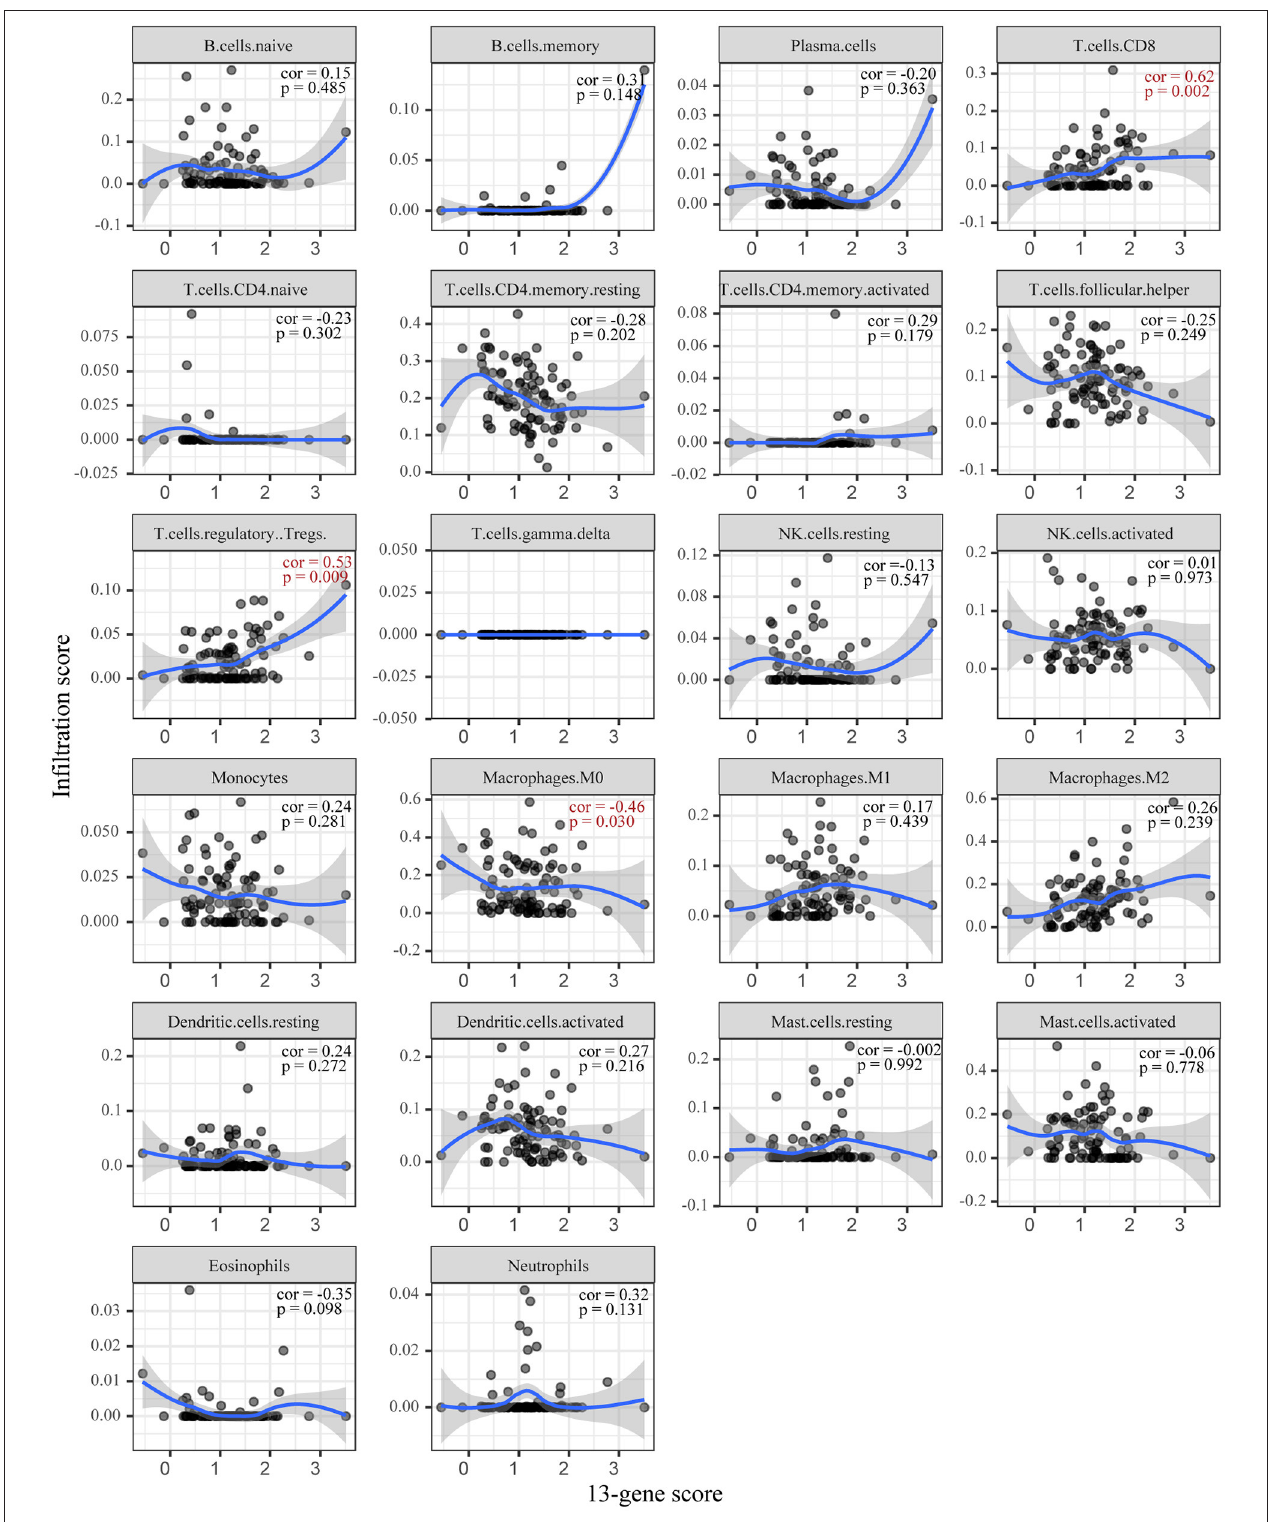
FIGURE 6 | The correlation between the 13-gene score and immune infiltration.